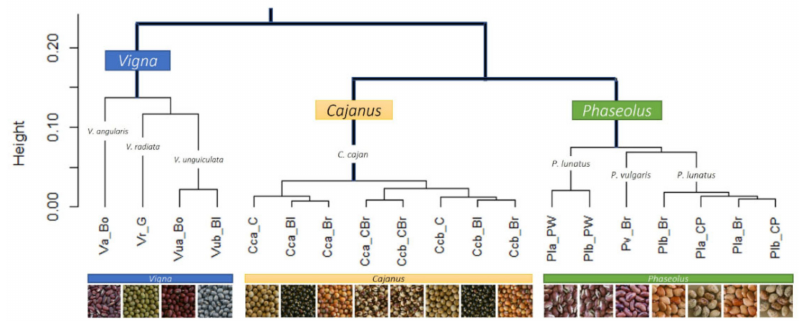
Figure 6. Cluster analysis of the mineral composition of the six legumes and their seed colour types.